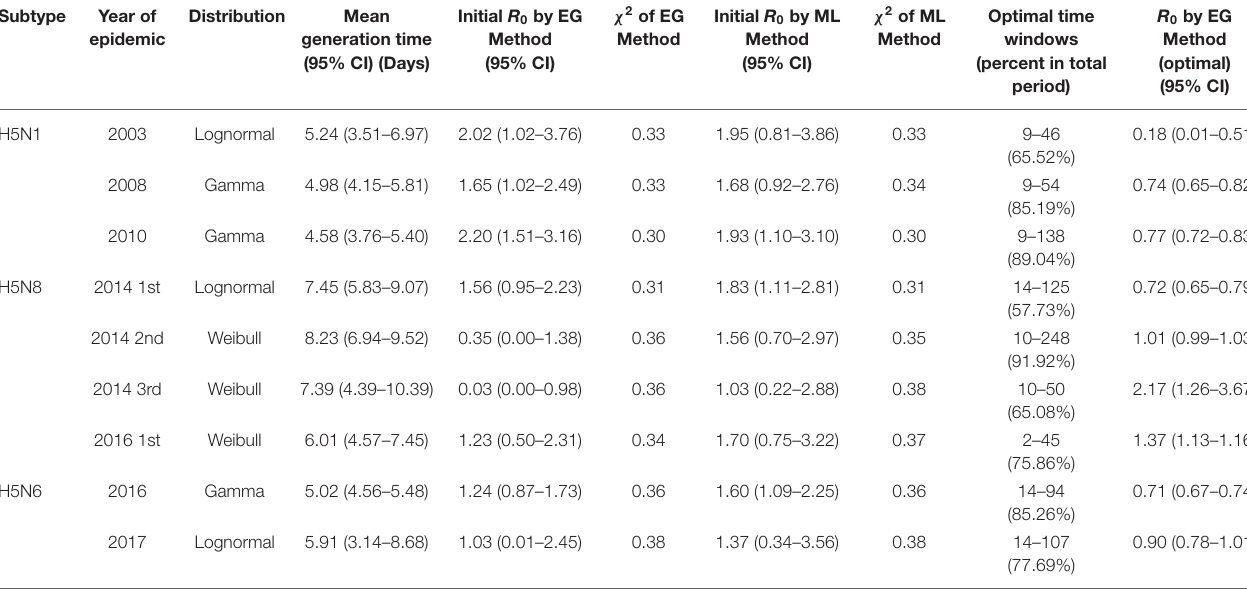
TABLE 2 | Generation time and reproduction number of HPAI by EG and ML method.